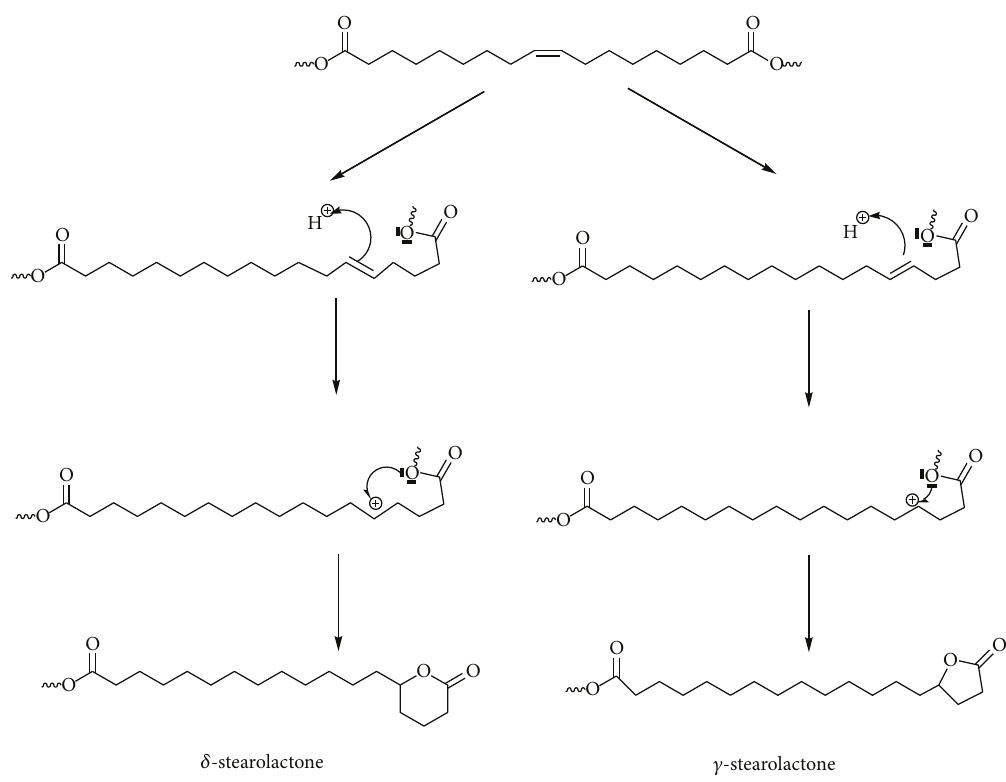
Scheme 3: Mechanism of the formation of δ -stearolactone and γ -stearolactone [46].